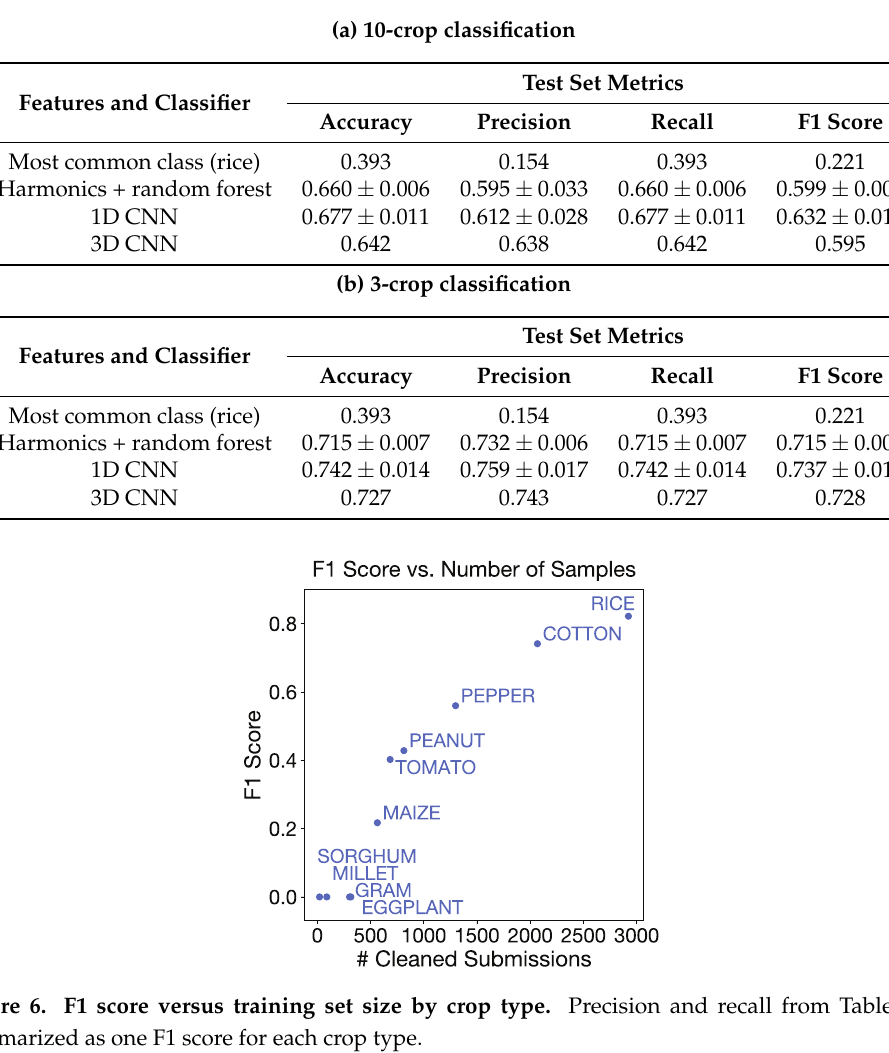
Table 3. Summary of crop type classification results. Overall accuracy and precision, recall, and F1 scores (weighted average across classes) are shown for models trained on Sentinel-1 and -2 combined features to classify ( a ) all 10 crops and ( b ) simplified 3-class task of rice, cotton, and other crops.